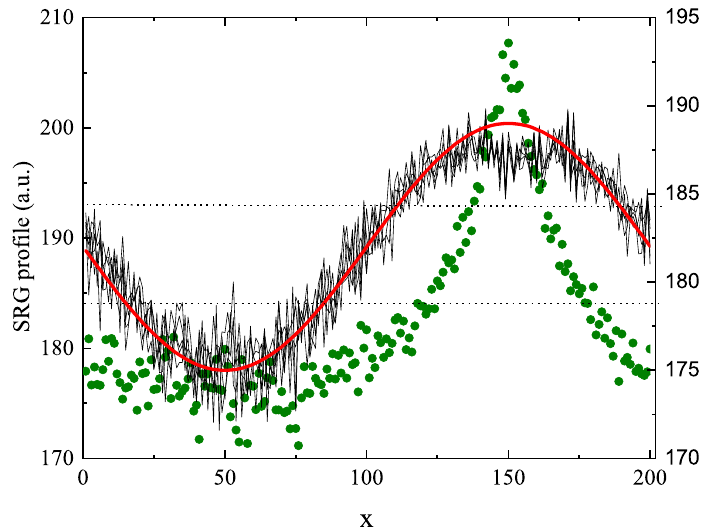
Figure 11. SRG profile in two limiting cases: weak stabilizing forces, end of the simulation (green circles, scale left) and strong stabilizing forces, the initial phase of build-up of SRG (thin black solid line, scale right). Thick red solid line: scaled sine function, dashed horizontal lines: initial surface